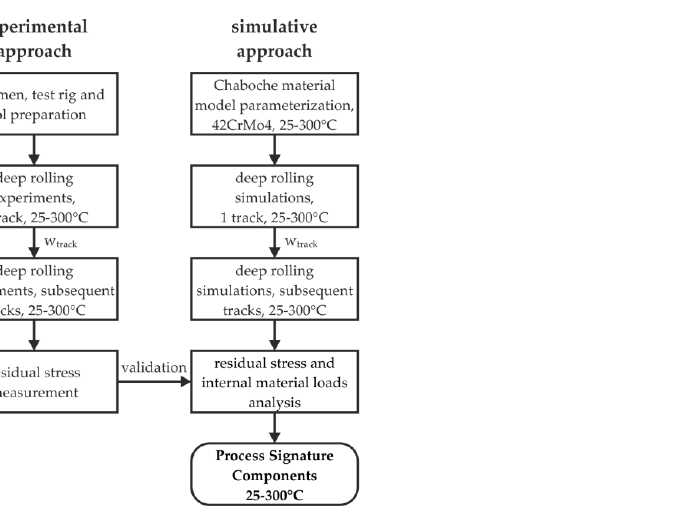
Figure 1. Procedure for the determination of temperature-dependent Process Signature Components.